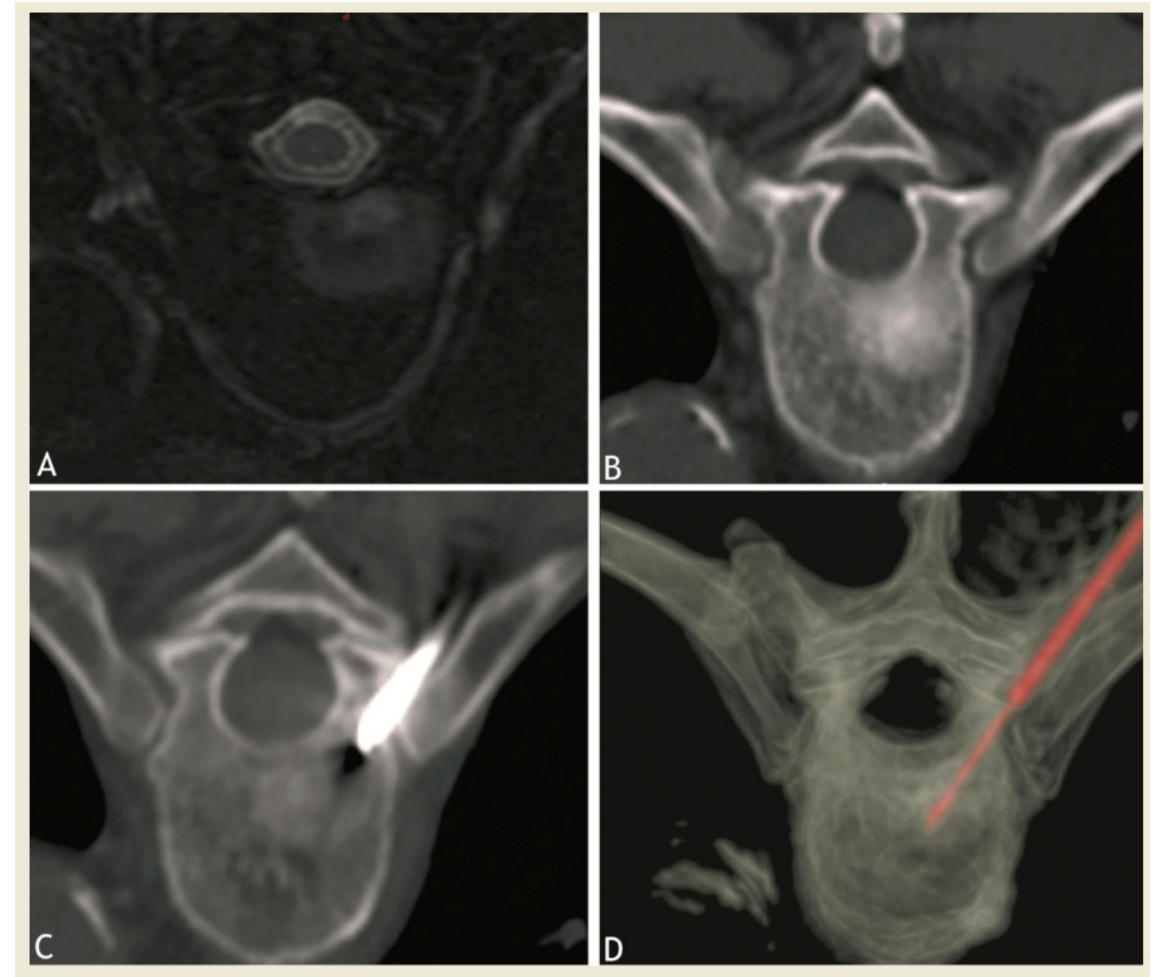
Figure 1. Axial MRI after gadolinium injection ( A ) and CT ( B ) showing a sclerotic-enhancing lesion of the vertebral body of fifth thoracic vertebra. ( C , D ): CT images showing the radiofrequency probe at target site in the lesion during thermoablation session.